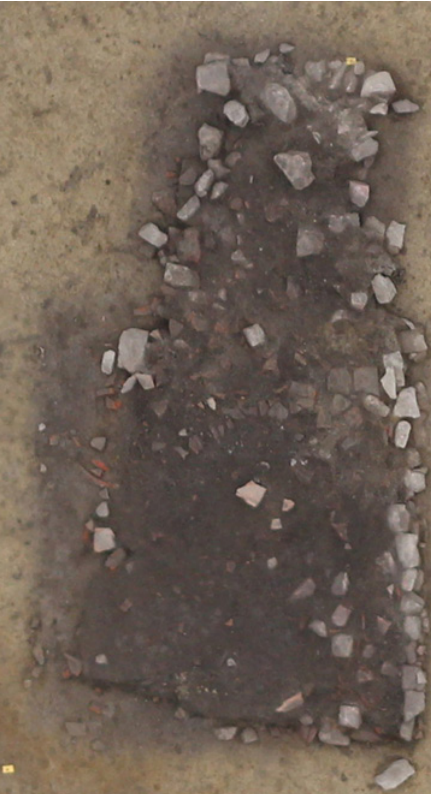
Figure 5: Detail of fig. 10 Neuhofen, Germany.